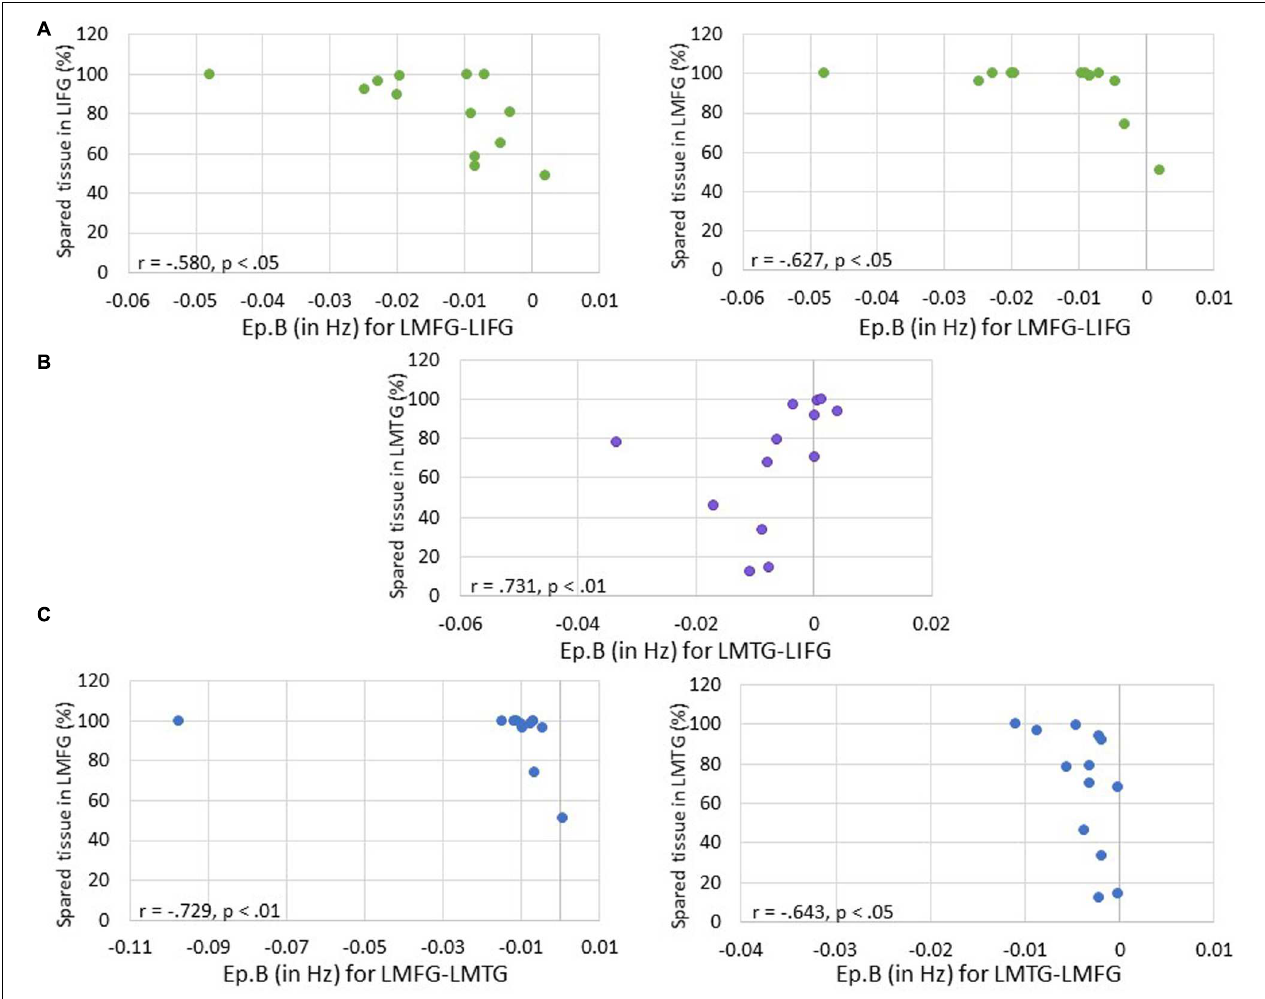
FIGURE 7 | Correlations between percentage of spared tissue and strength of the connections (i.e., Ep.B values in Hz). (A) For family #1, significant correlations were found between the connection strength of LMFG → LIFG and the percentage of spared tissue in LIFG (shown on the left) and LMFG (shown on the right). (B) For family #2, a significant correlation was found between the connection strength of LMTG → LIFG and the amount of spared tissue in LMTG. (C) For family #3, significant correlations were found between the connection strength of LMFG → LMTG and percentage spared tissue in LMFG as well as the connection LMTG → LMFG and the amount of spared tissue in